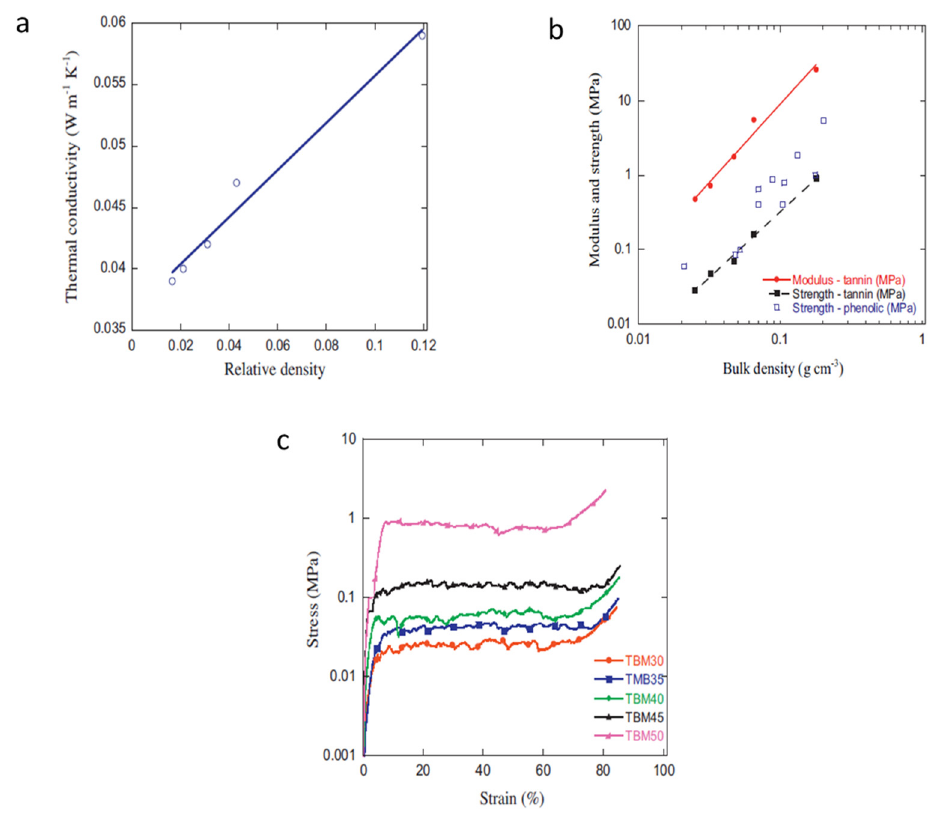
Figure 13. a : Thermal conductivity; b compressive modulus; and c stress–strain curves